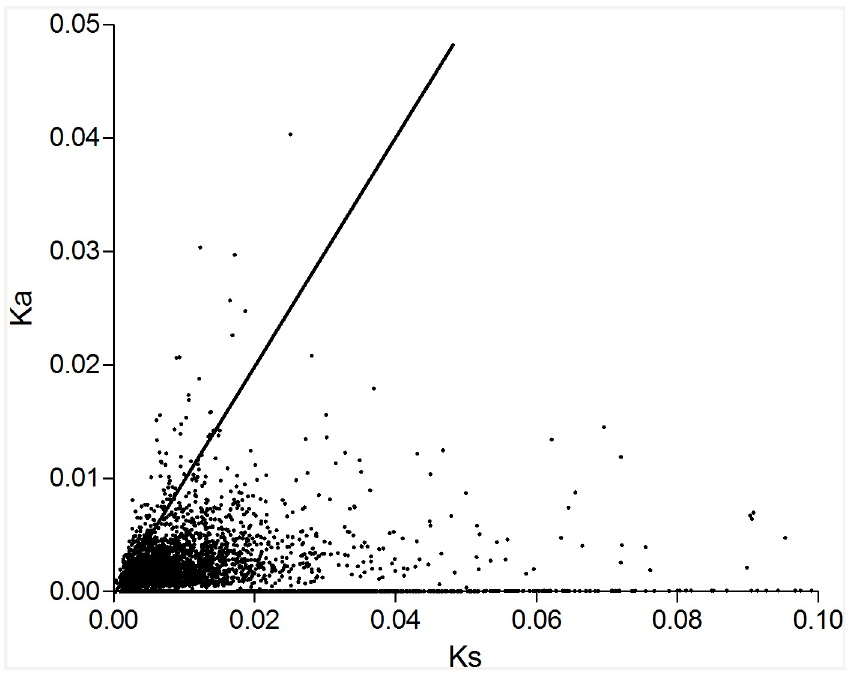
Fig 4. Plotting of the ratio of Ka/Ks of putative orthologous genes between black and red common coral trout, where the line indicates Ka/Ks =